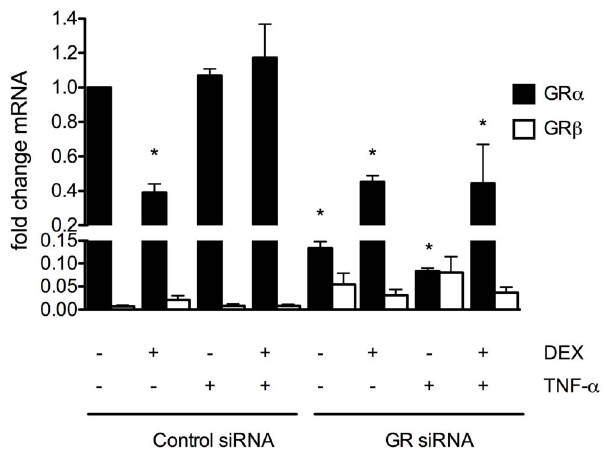
Figure 5. Expression profile of GR a and GR b mRNA in endothelial cells. Real time PCR analysis was performed on mouse lung endothelial cells treated as described. Values were normalized to untreated control siRNA GR a levels and represent mean 6 SEM for 3 independent samples. Cells were isolated from C57/BL6 mice. *p , 0.05 compared to untreated control siRNA GR a levels.